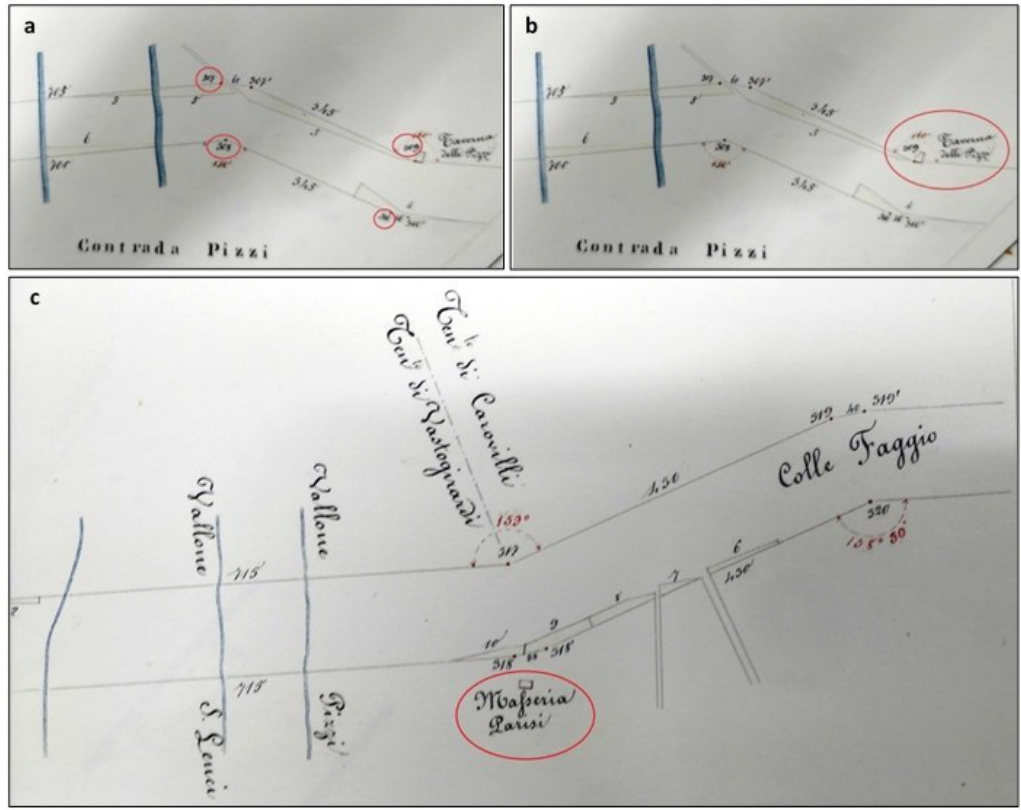
Figure 4. Heritage signs of the Celano‑Foggia drove road in the territory of Vastogirardi (red circles): ( a ) Limit stones. Source: National Archives of Foggia, Atlante 118, p. 23; ( b ) Taverna delli Pizzi. Source: National Archives of Foggia, Atlante 118, p. 23; ( c ) Masseria Parisi. Source: National Archives Foggia, Atlas 118, p.